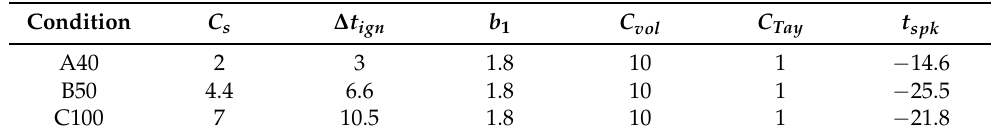
Table 5. Combustion model’s tuning constants for the different operating conditions. ∆ t ign and t spk are in